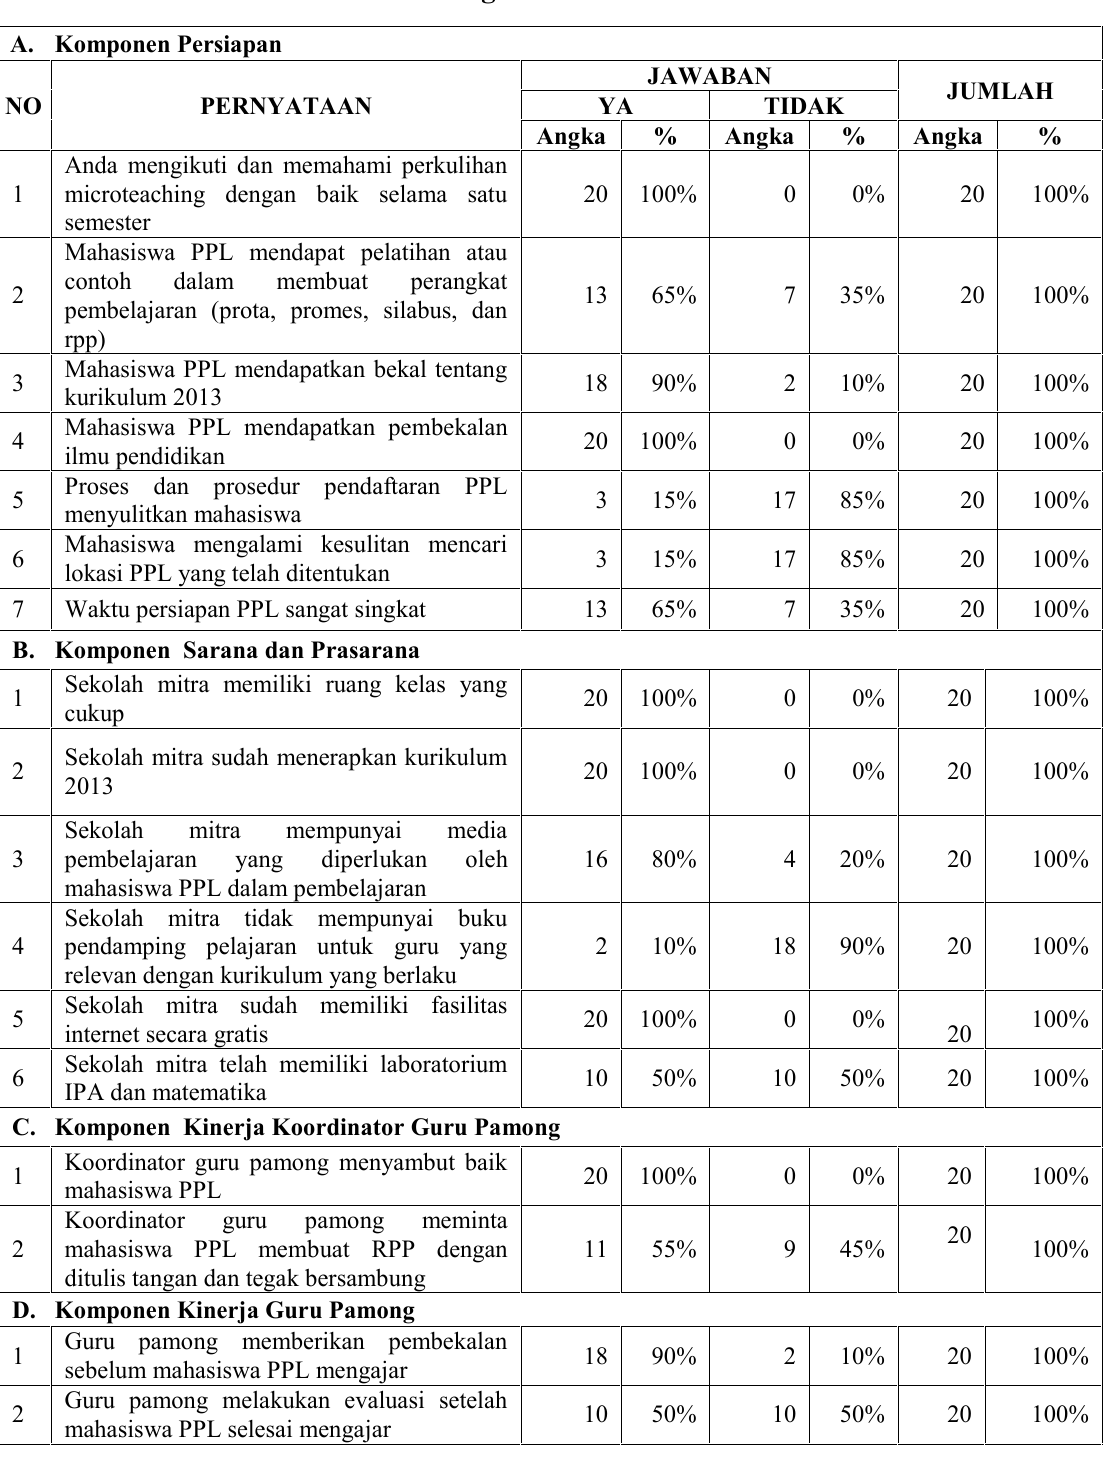
Tabel 1. Rekapitulasi Data Hasil Angket Persepsi Mahasiswa Semester VII PGSD terhadap Pelaksanaan PPL FKIP UMS Tahun 2013/2014 di Sekolah